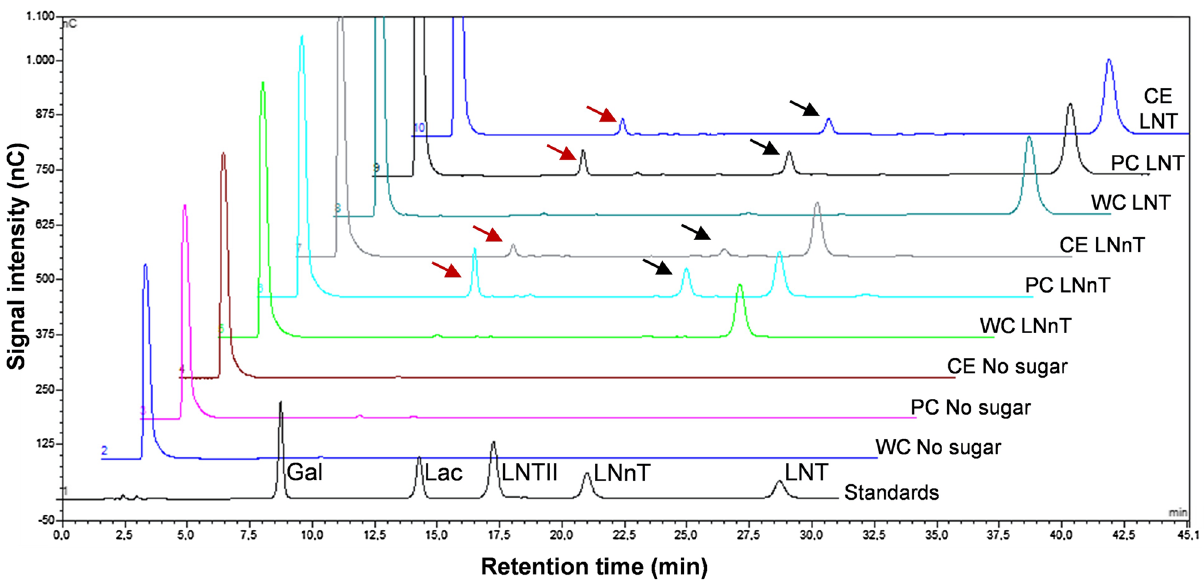
Figure 3. HPLC chromatograms (Dionex system) of standard compounds mixture (chromatogram 1) and reaction mixtures containing Bifidobacterium dentium Y510: whole cells (WC) without sugar (chromatogram 2), with LNnT (chromatogram 5) or LNT (chromatogram 8); permeabilized cells (PC) without sugar (chromatogram 3), with LNnT (chromatogram 6) or LNT (chromatogram 9) and cell-free crude extracts (CE) without sugar (chromatogram 4), with LNnT (chromatogram 7) or LNT (chromatogram 10). The red and black arrows showed the Gal and LNTII, respectively present in the reaction mixtures. LNT lacto- N -tetraose, LNnT lacto- N -neotetraose, LNTII lacto- N -triose, Lac lactose, Gal galactose, nC